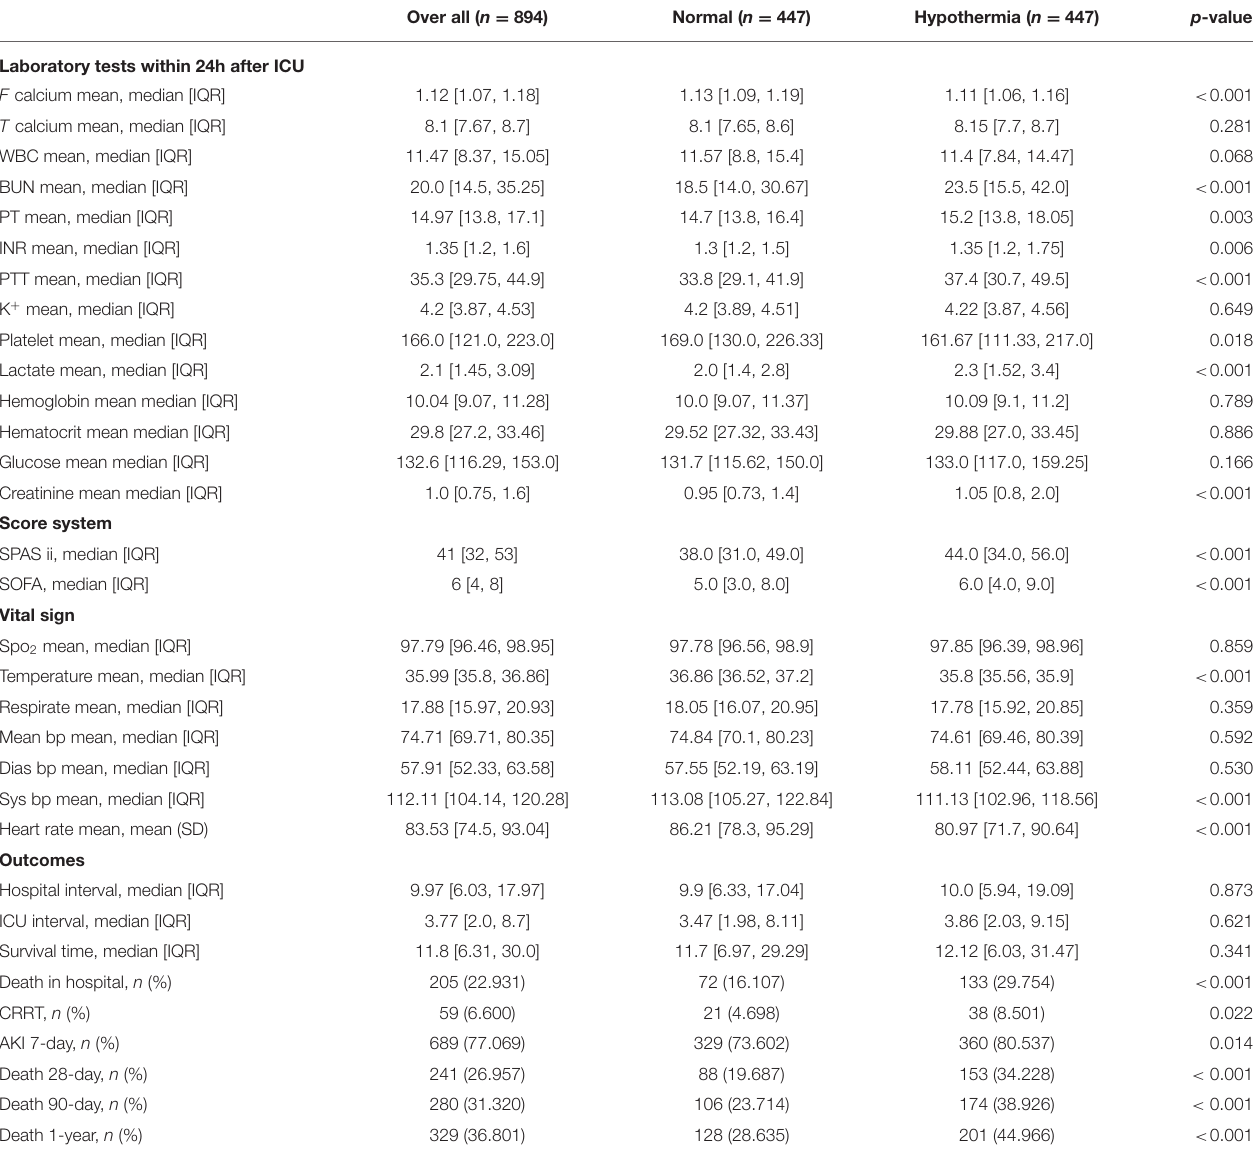
TABLE 2 | Post-PSM matched between hypothermia and normal group. Over all ( n = 894) Normal ( n = 447) Hypothermia ( n = 447) p